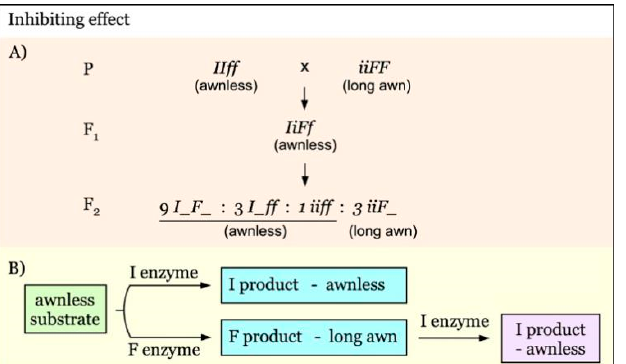
Figure 6. Model of interaction of awnness genes with an inhibiting effect. ( A ). Awnness gene I inhibits the dominant expression of the F gene. ( B ). In the presence of I enzyme, the conversion of the awnless substrate is inhibited, giving awnless phenotype. In the lack of I enzyme, F enzyme will catalyze the awnless substrate into long awn product. When both F and I enzymes are present, I could inhibit F enzyme, resulting in the awnless phenotype. The final awn phenotype is determined by the presence of the epistatic gene with the highest supremacy (Figure 7B) [21]. The expected F 2 segregation ratio would be 48:12:3:1